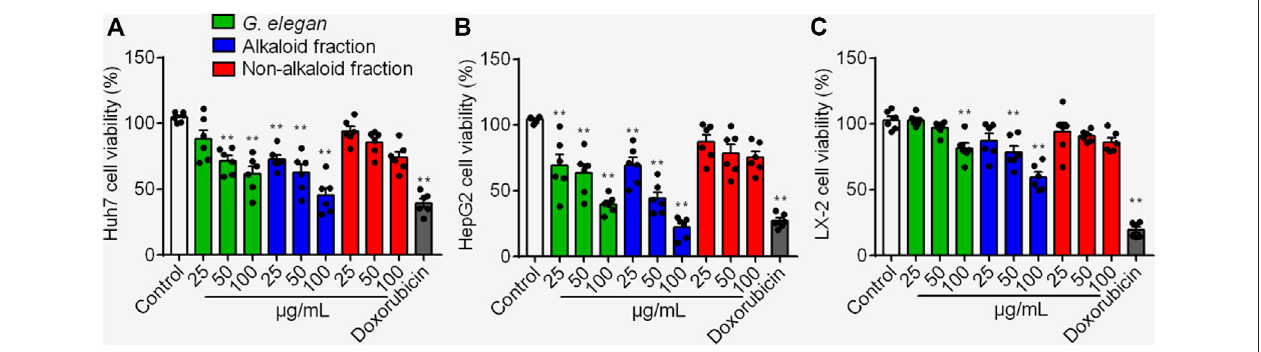
FIGURE 1 | The cytotoxic effects of the alkaloid fraction, non-alkaloid fraction, and whole extracts of G. elegans on Huh7 (A) HepG2 (B) and LX-2 (C) cells. Cell viability was assayed for 24 h ** p < 0.01 vs . Control.